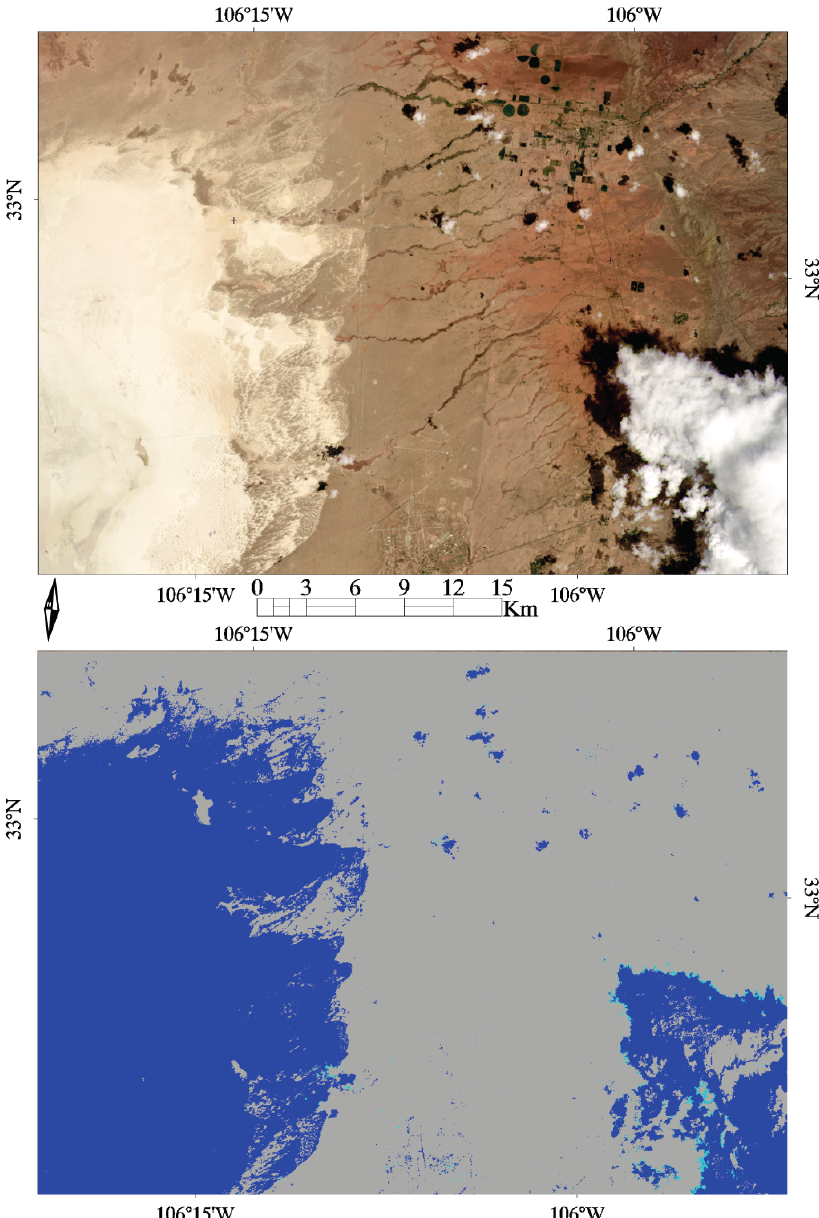
Figure 4. Illustration of Landsat 8 cloud mask commission errors over highly reflective exposed soils/sands (West side) and also correctly detected cloud (East side). True color Landsat 8 reflectance ( top ); Landsat 8 cloud mask shown colored as high confidence clouds (dark blue), medium confidence clouds (light blue), low confidence clouds (grey) ( bottom ). Landsat 8 1530 × 1110 30 m pixel subset acquired 24 July 2013 over White Sands, New Mexico (path 33, row